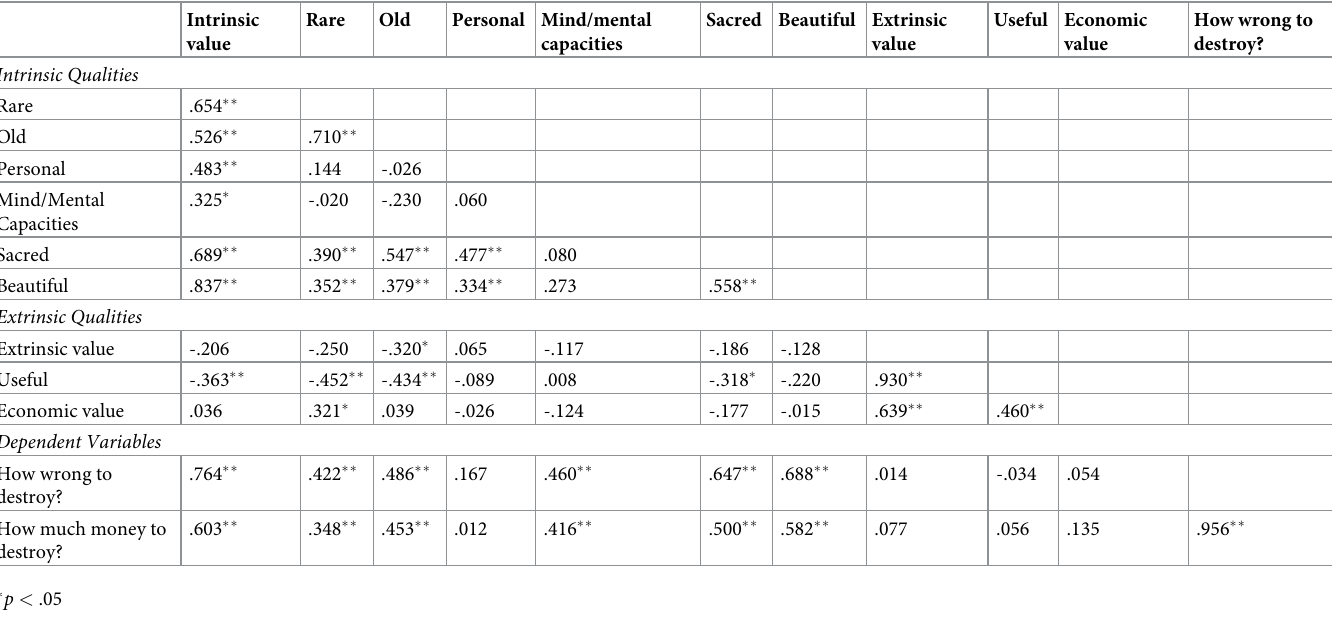
Table 3. Correlations between average ratings for Study